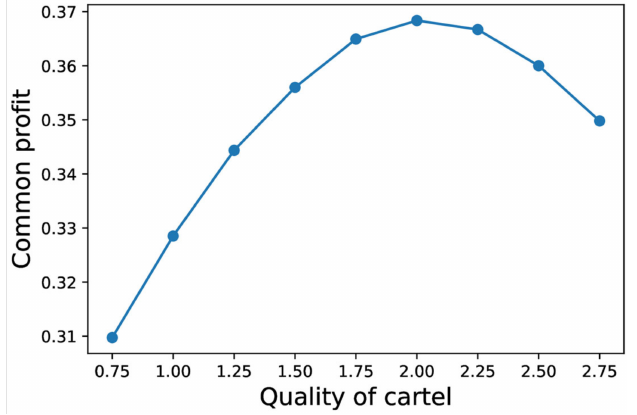
Figure 6. Profit of the cartel as function of quality of the